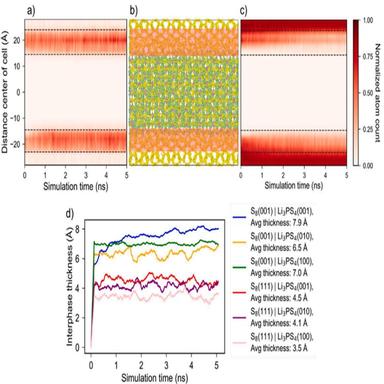
.1. MLIP-based molecular dynamics simulation of a S8/β-Li3PS4 interface showing the spatial distribution of Sx=∕8 (a) and S8 (c) species along the S8(001)/ Li3PS4(001) interface structure shown in (b). Notice how the simulations predict that all the interphases grow very rapidly (within the first 100 ps), but they reach different steady state thicknesses (ranging from 3.5 Å to 7.9 Å) depending on the initial considered interface morphology (d). In (b), green, purple, and yellow balls stand for Li, P, and S